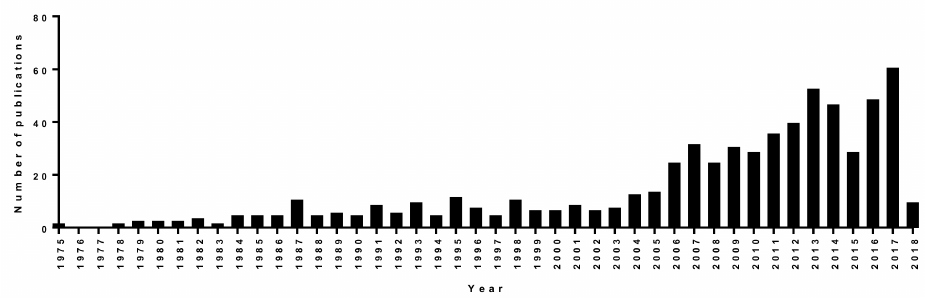
Figure 2. Global publication records (1st January 1975–25th February 2018) containing the keywords “magnetotactic bacteria or magnetosome(s)” in article titles [7,8]. For analysis of the raw data, see Table S2. The criteria used for selection of data are detailed in the “Database generation & analysis